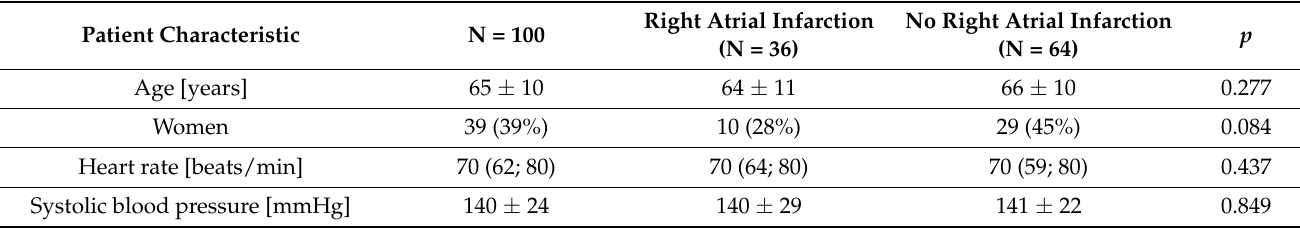
Table 2. Patient characteristics, laboratory test, echocardiography findings and concomitant treatment in the whole study group and by subgroups depending on the diagnosis of right atrial